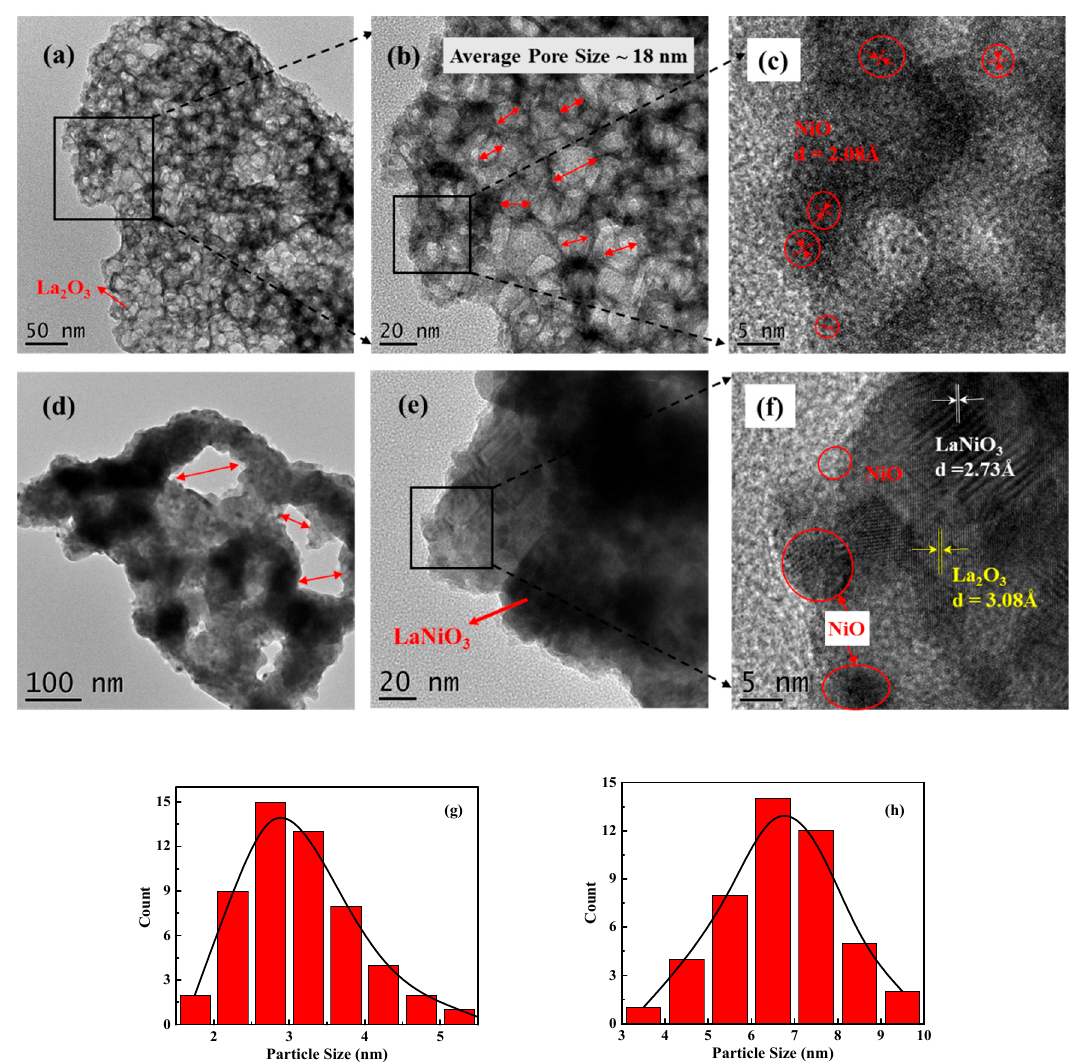
Figure 3. TEM images and NiO particle size distributions of fresh catalysts: ( a – c , g ) 50% Ni–La 2 O 3 –M and ( d – f , h ) 50% Ni–La 2 O 3 .